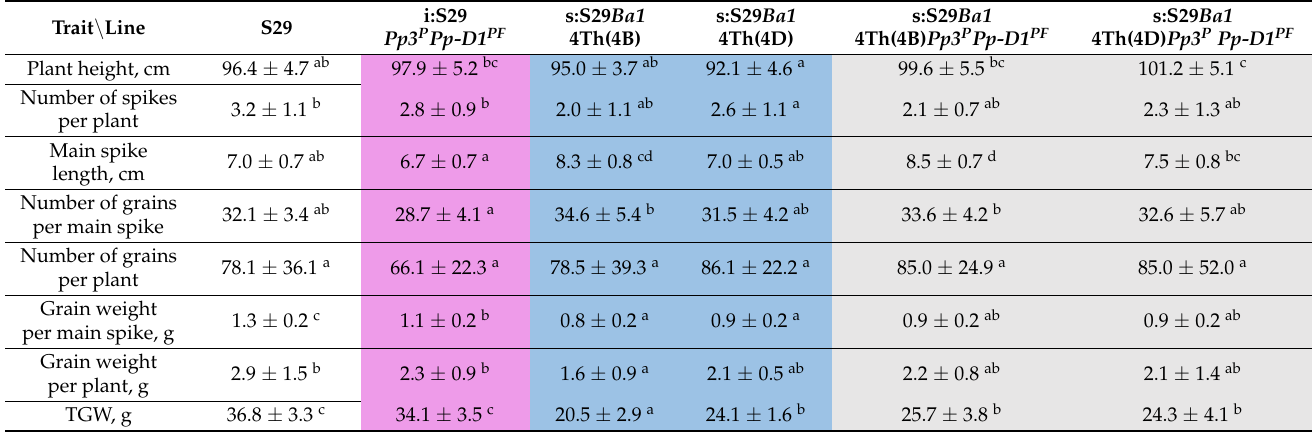
Table 3. Characteristics of the lines possessing different combinations of anthocyanin pigments. Data are presented as the mean ±